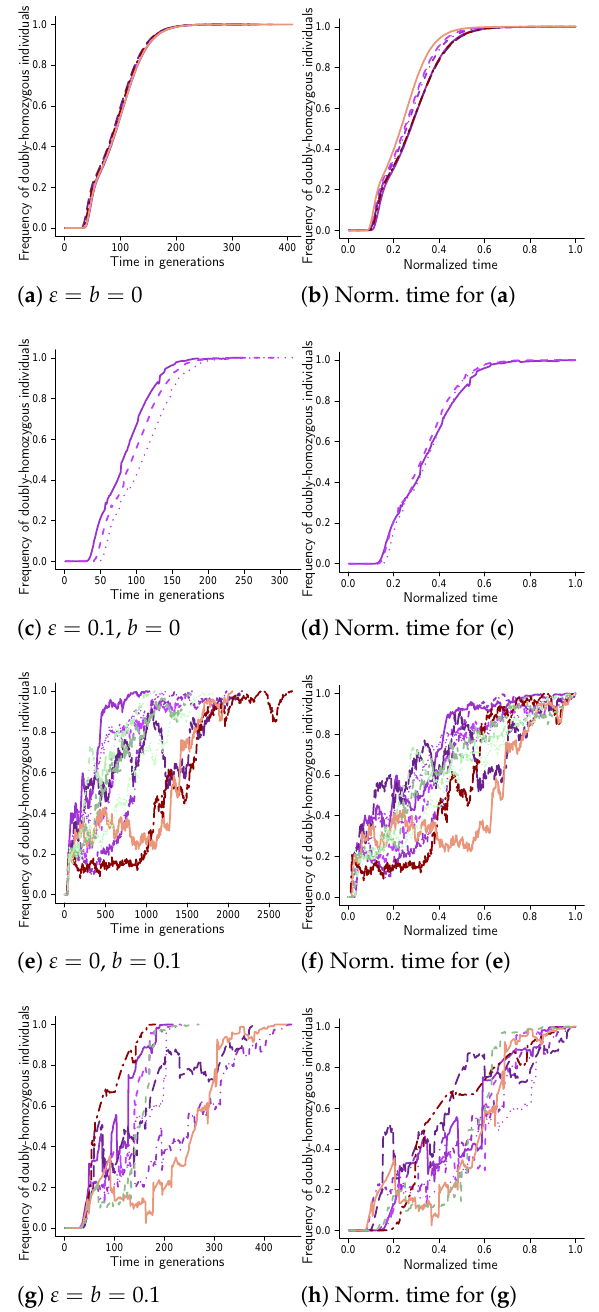
Figure A5. Three sites with weight function as in Equation (A5). Examples of fixation trajectories at three sites with weight function as in Equation (A5), carrying capacity C = 10 6 , cutoff u ( N ) = C , probability of recombination r = 0.25 between adjacent sites, α 1 = 0.75, α 2 = 3, ε (see Equation (7)) and probability of a bottleneck b as shown, strength of selection s = 0.1 and bottleneck B = 10 3 ; excursions’ trajectories from ten trials in ( a , c ) and from 10 2 trials in ( e , g ). Each trajectory traces, as a function of time, the number of diploid individuals homozygous for the fit type at all sites relative to the population size (the number of diploid individuals). The panels on the right ( b , d , f , h ) show the corresponding excursions from the left panels ( a , c , e , g ), where the time to fixation for each excursion is normalized by the time to fixation for the excursion. The scale of the abscissa (time axis) may vary between panels; in each panel, the trajectories were all obtained under identical